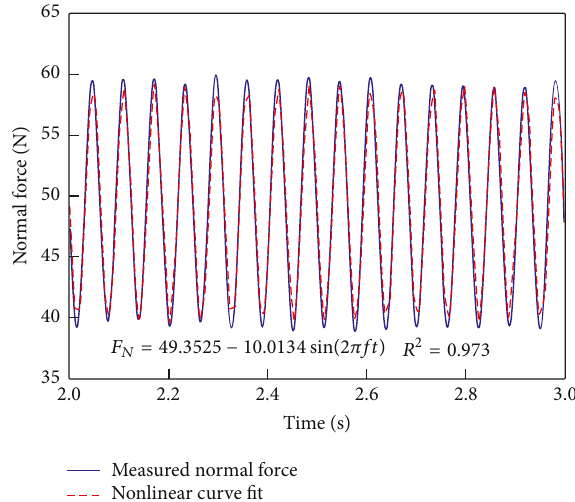
Figure 12: Normal force data obtained in real-time monitoring and the fitting curve